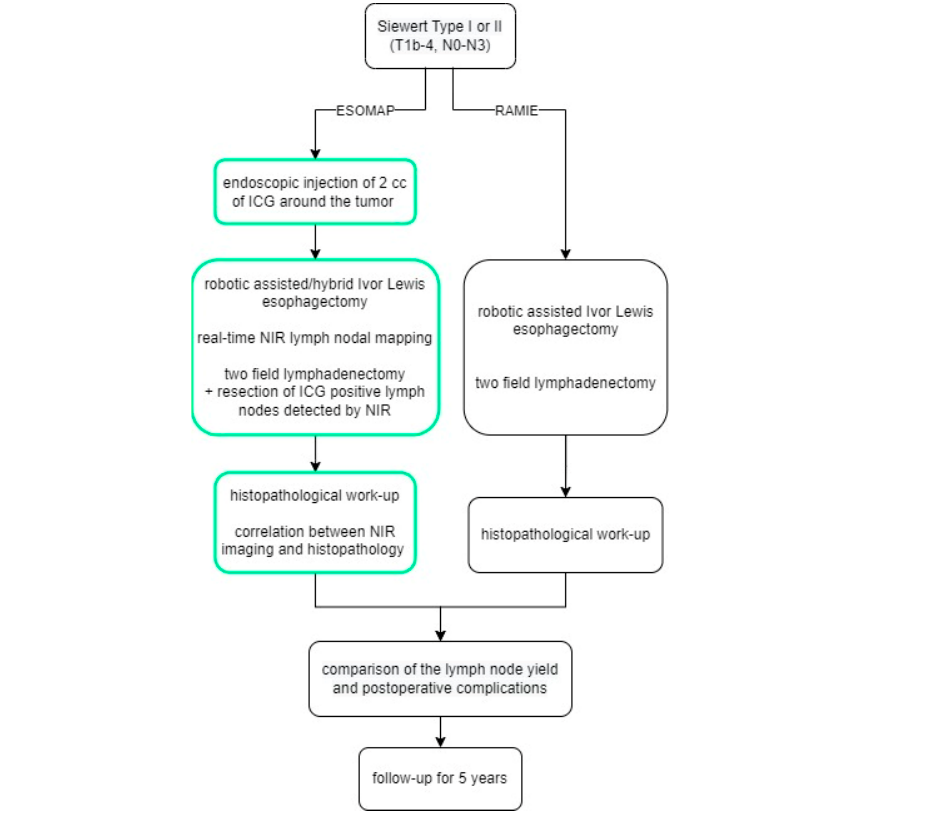
Figure 1. The ESOMAP